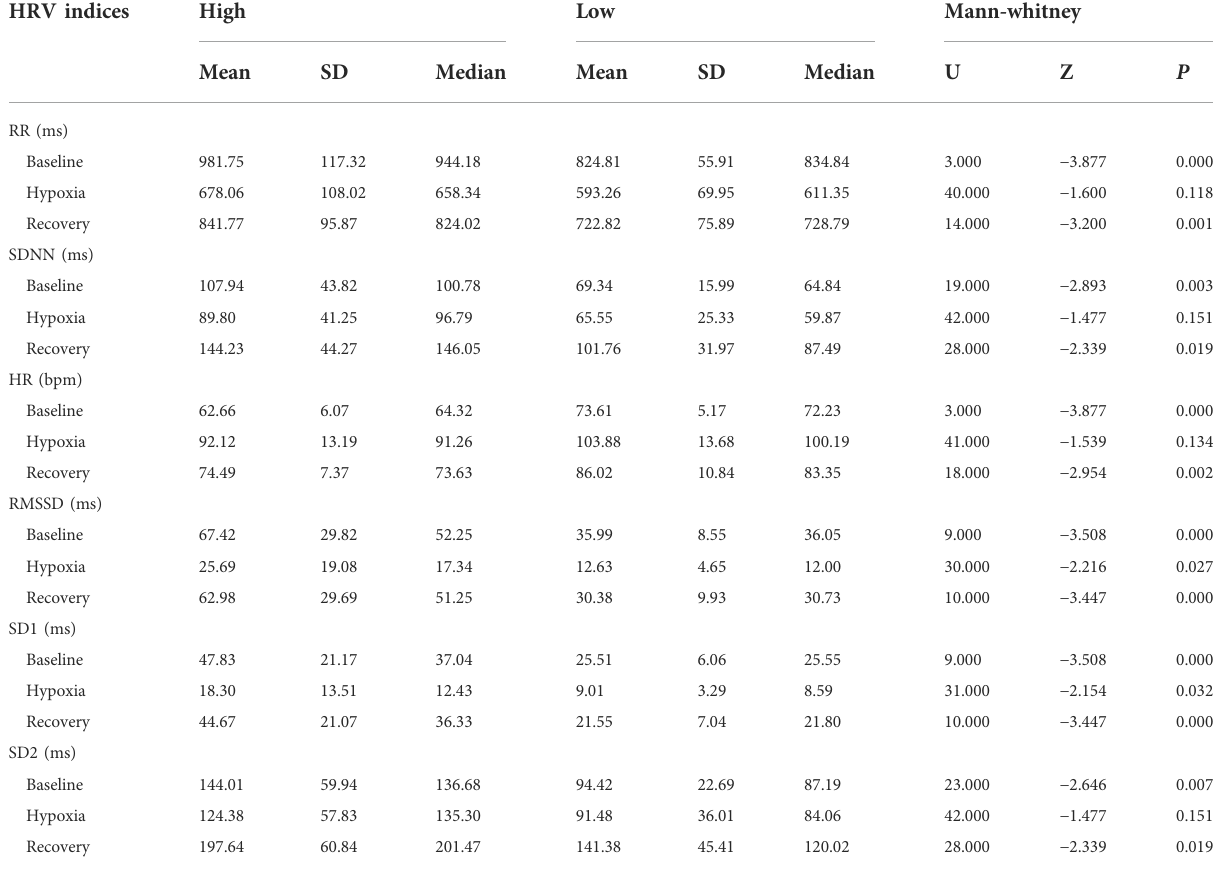
TABLE 2 Heart rate variability during baseline, hypoxia, and recovery. High Low